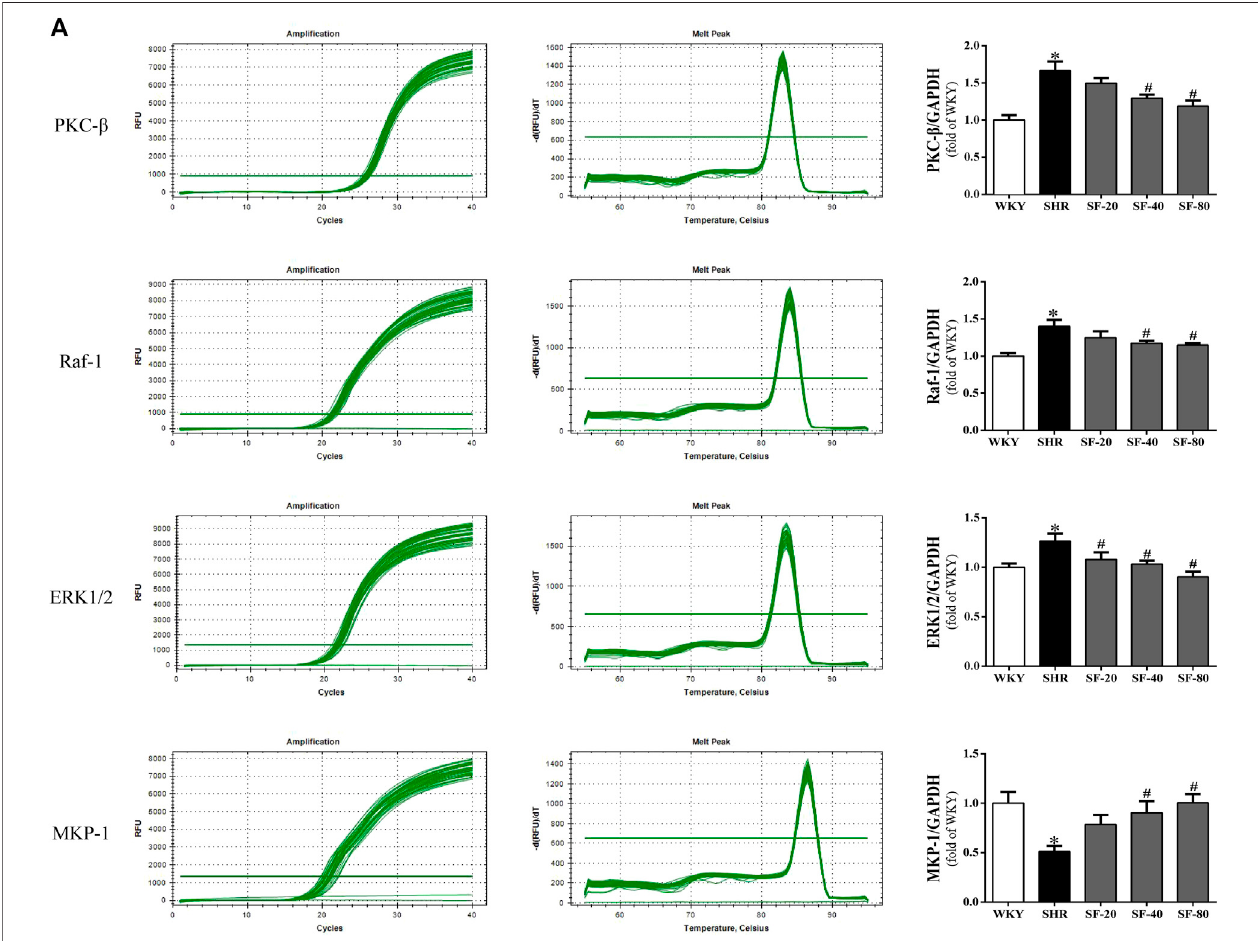
FIGURE 7 | SF improves cardiac hypertrophy by regulating PKC- β , Raf-1, ERK1/2, and MKP-1 levels. (A) Quantitative analysis of PKC- β , Raf-1, ERK1/2, and MKP-1 mRNA levels. ( n (cid:1) 5). (B) quantitative analysis of PKC- β , Raf-1, ERK1/2, and MKP-1 protein levels. ( n (cid:1) 3). The levels of PKC- β , Raf-1, and ERK1/2 were signi fi cantlyupregulatedandthelevelofMKP-1wassigni fi cantlydownregulatedinthemyocardiumofSHRsatthetranscriptionalandtranslationallevels.SFsigni fi cantly downregulated the levels of PKC- β , Raf-1, ERK1/2, and signi fi cantly upregulated the level of MKP-1 in the left ventricular myocardial tissue of SHRs. Data are presented as mean ± SEM. *signi fi cantly different from WKY at p < 0.05; # signi fi cantly different from SHRs at p < 0.05.